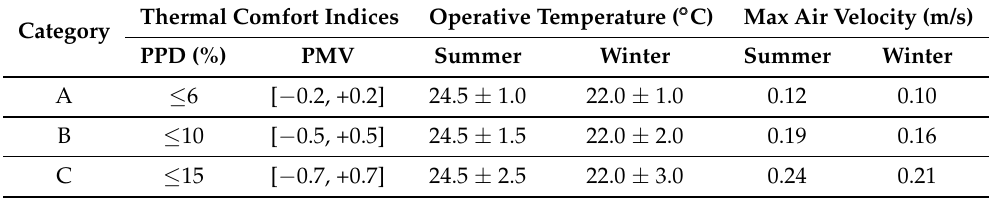
Table 1. Acceptable operative temperature and operative temperature band for thermal comfort in office buildings based on ISO 7730 [9]. PPD, Predicted Percentage of Dissatisfied people; PMV, Predictive Mean